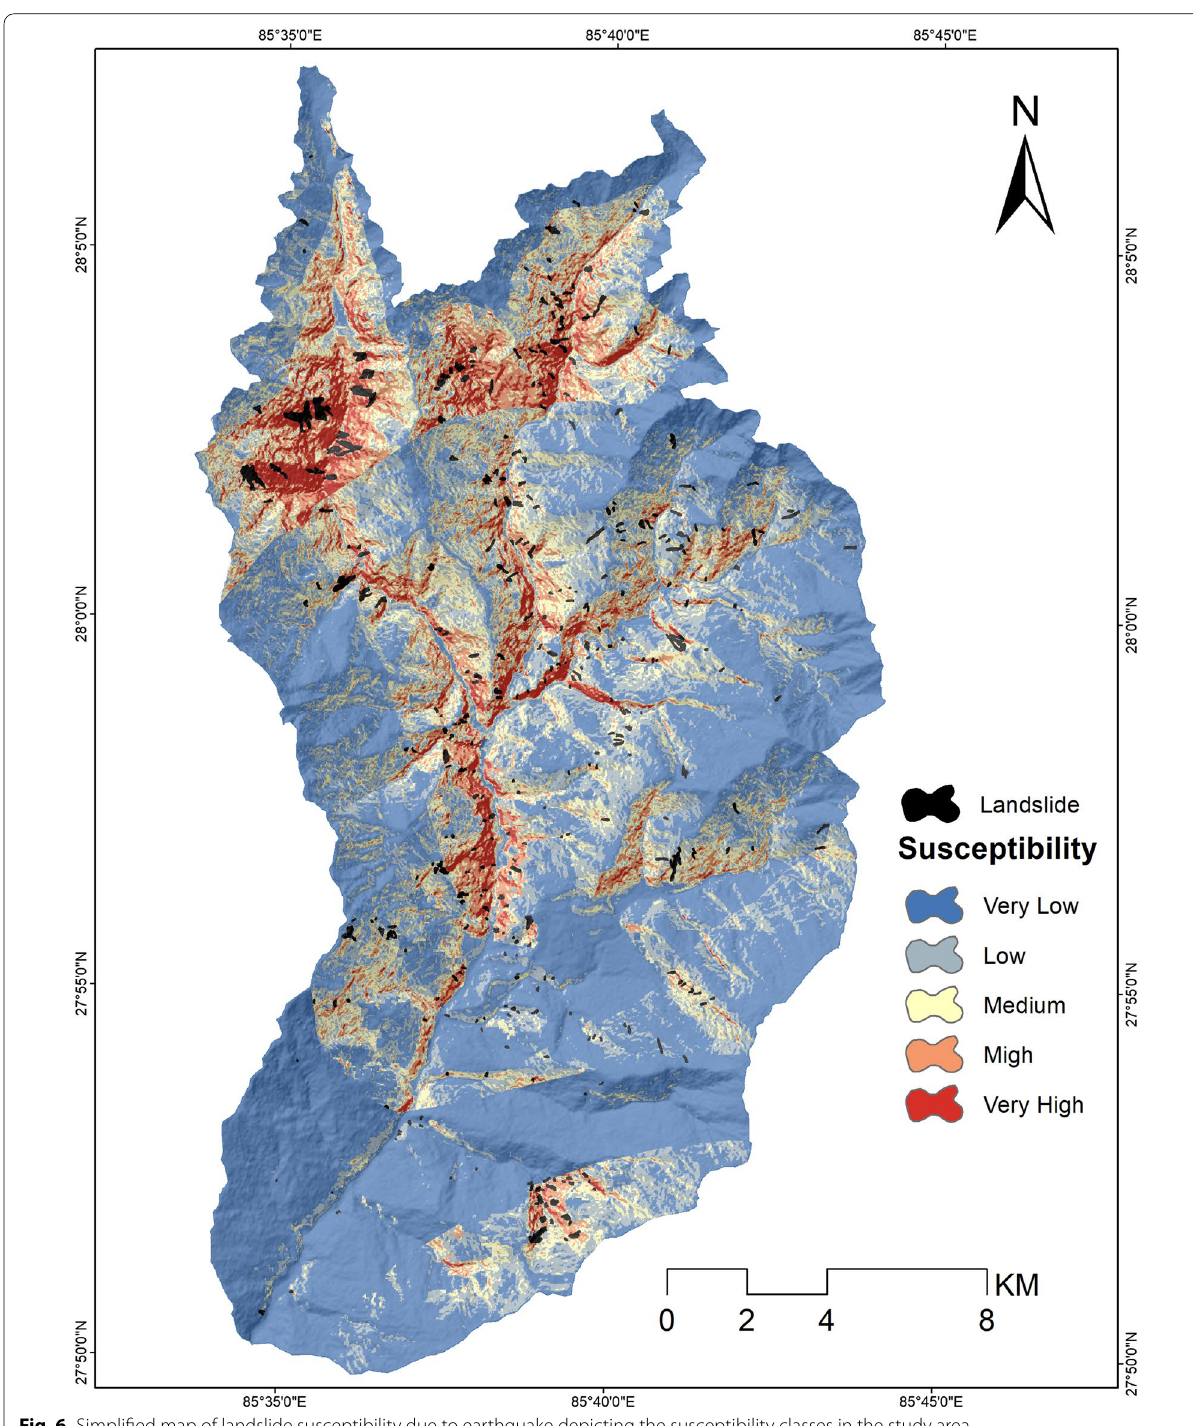
Fig. 6 Simplified map of landslide susceptibility due to earthquake depicting the susceptibility classes in the study